Question: Which kind of chart has been used to present this data?
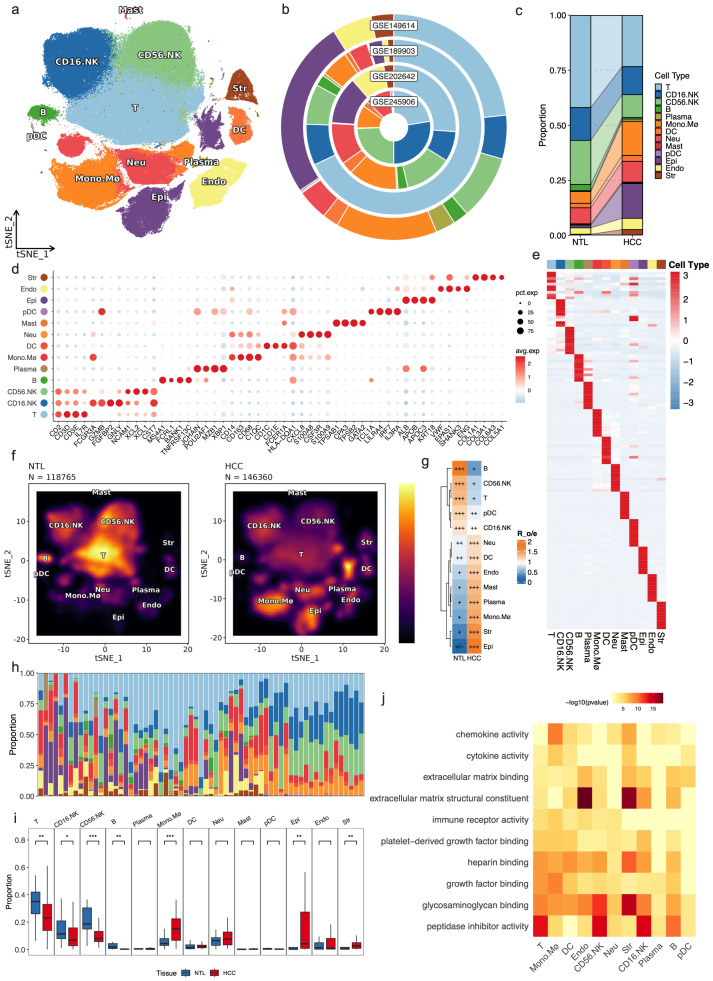
Answer: heatmap